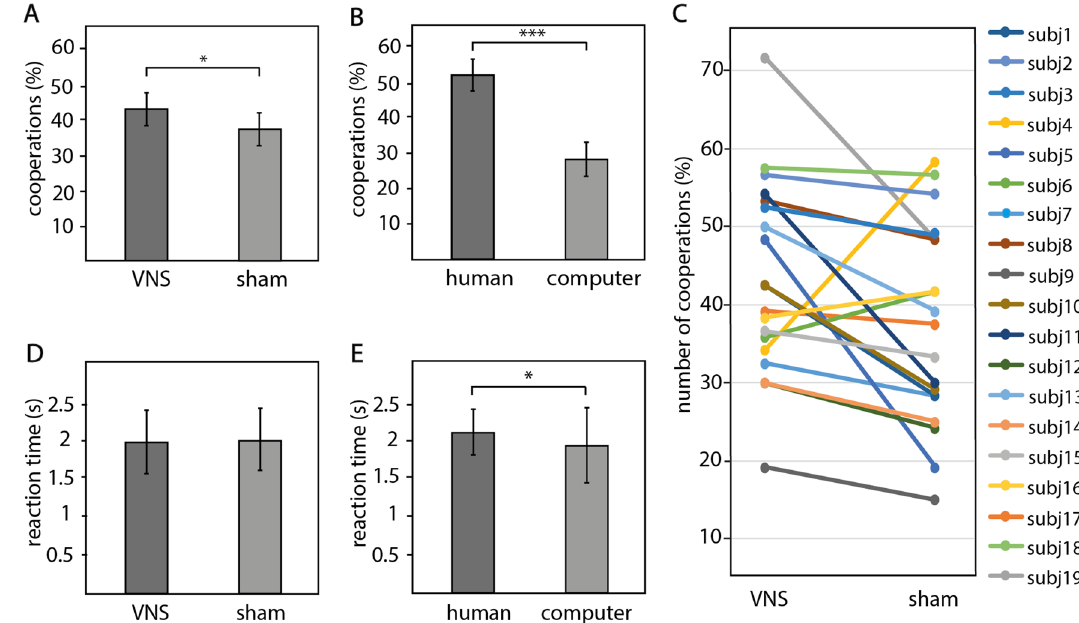
Figure 2. Effect of stimulation on cooperation and reaction times. ( A – C ) Average cooperation scores (%) ( A ) for each stimulation condition (tVNS/sham) and ( B ) each opponent (human/computer). Repeated measures ANOVA revealed a main effect of “stimulation” (F 1,18 = 5.17, p = 0.035) and “opponent” (main effect opponent: F 1,18 = 24.21, p < 0.001). ( C ) Individual cooperation score (%) for each patient during both stimulation conditions. ( D , E ) Average reaction time for each ( D ) stimulation condition and ( E ) opponent. Repeated measures ANOVA demonstrated a main effect “opponent” on reaction times (F 1,18 = 4.76, p = 0.043). Bar graphs illustrate mean ± SEM parameters across